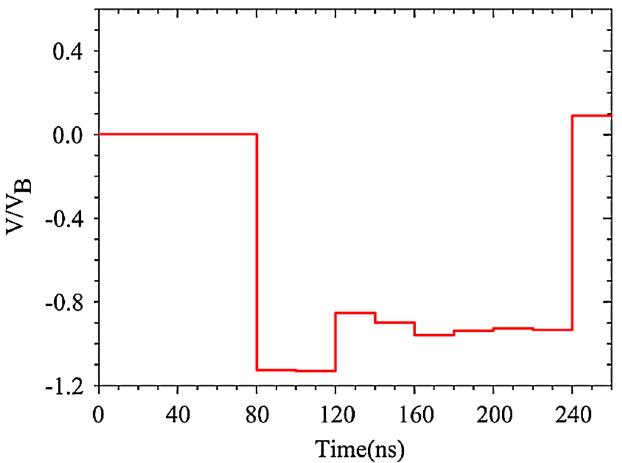
FIG. 6. (Color) Output voltage of the IEBA-A from the theo- retical calculation when Z 1 ¼ 6 : 2 (cid:6) , Z 3 ¼ 6 : 2 (cid:6) , Z 2 ¼ 9 (cid:6) , ¼ 10 (cid:6) , (cid:1) ¼ 70 ns , (cid:1) ¼ 10 ns . Z L 1 2